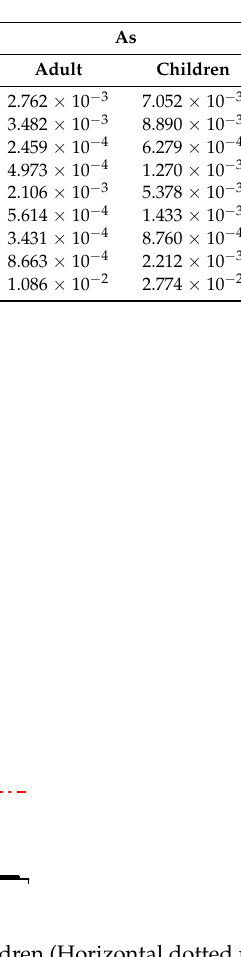
Figure 3. Total target hazard quotient (TTHQ) of trace elements from consuming vegetables of adults and children (Horizontal dotted red line indicates the threshold value of hazard quotient).